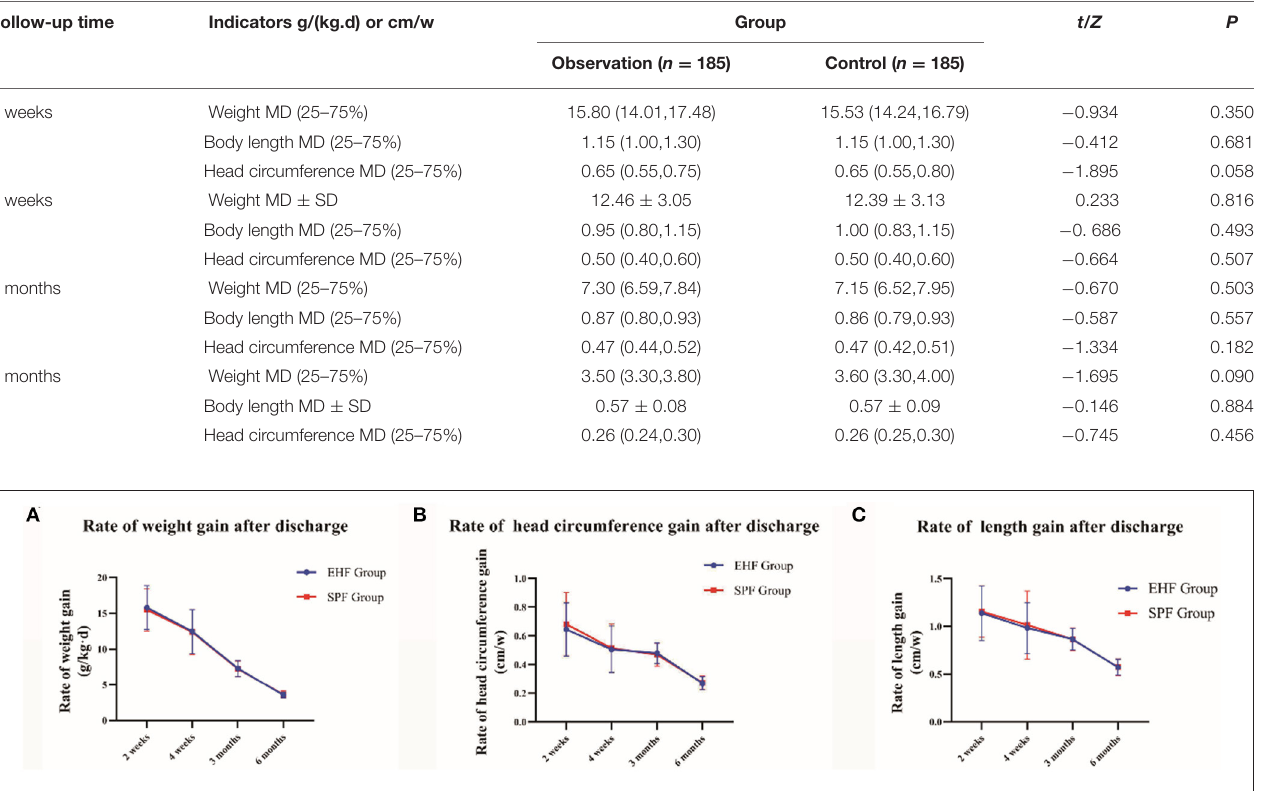
TABLE 9 | Comparison of the growth and development indexes of the two groups of premature infants after discharge from hospital. Follow-up